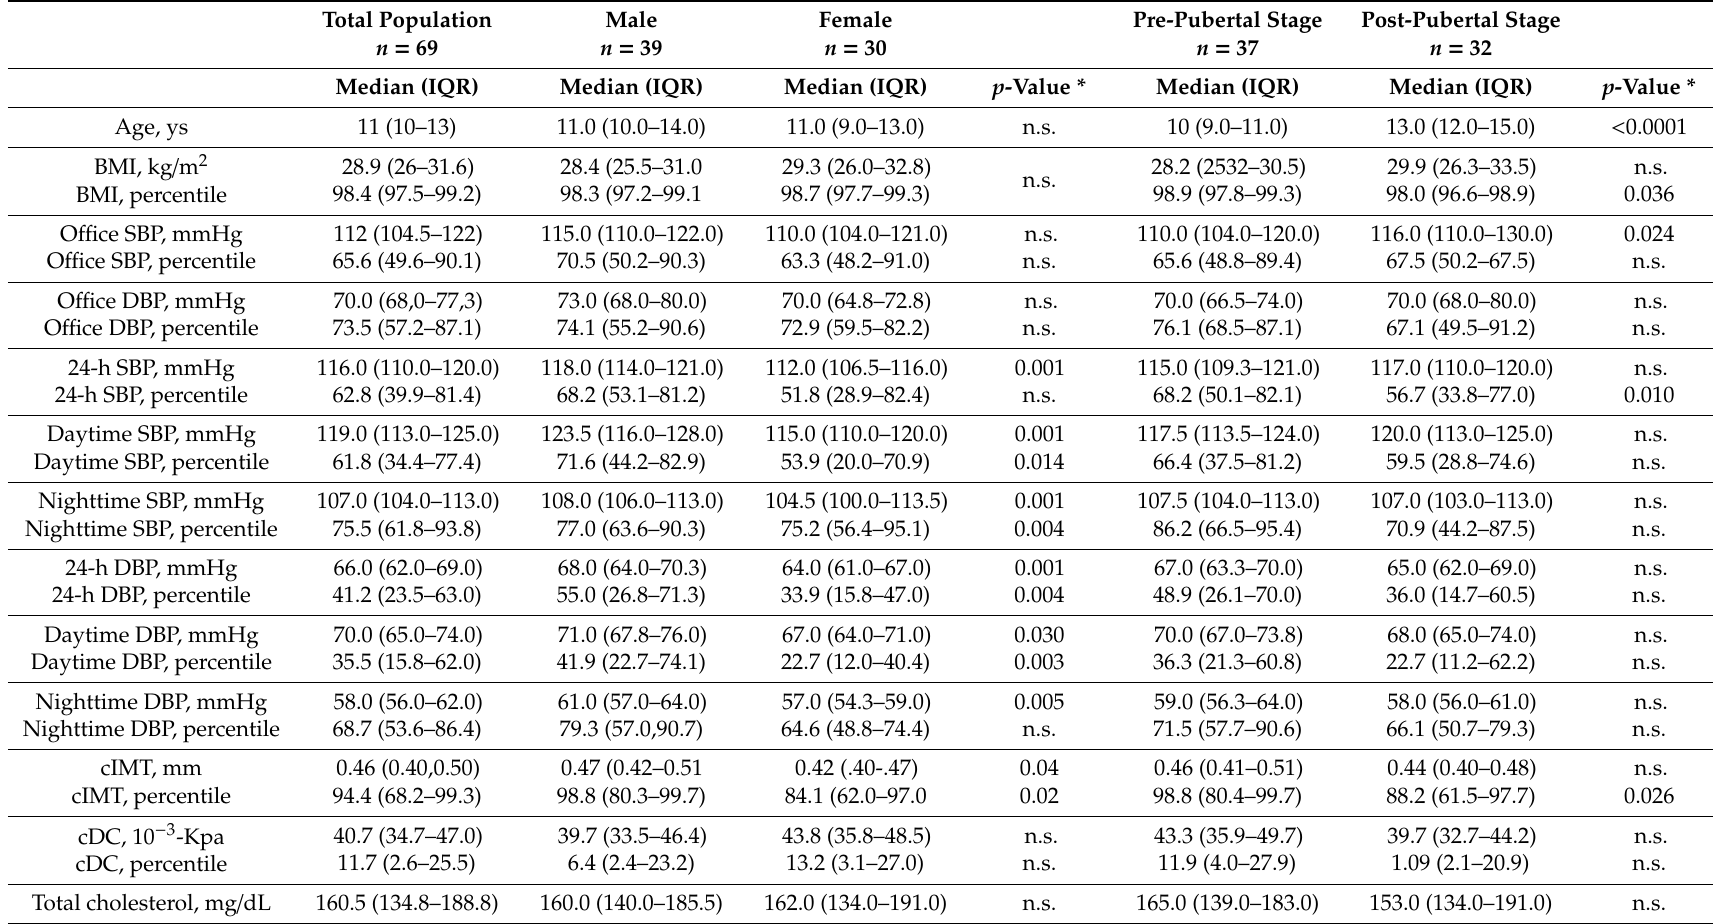
Table 1. General characteristics of the 69 obese children and adolescents divided according to sex and pubertal